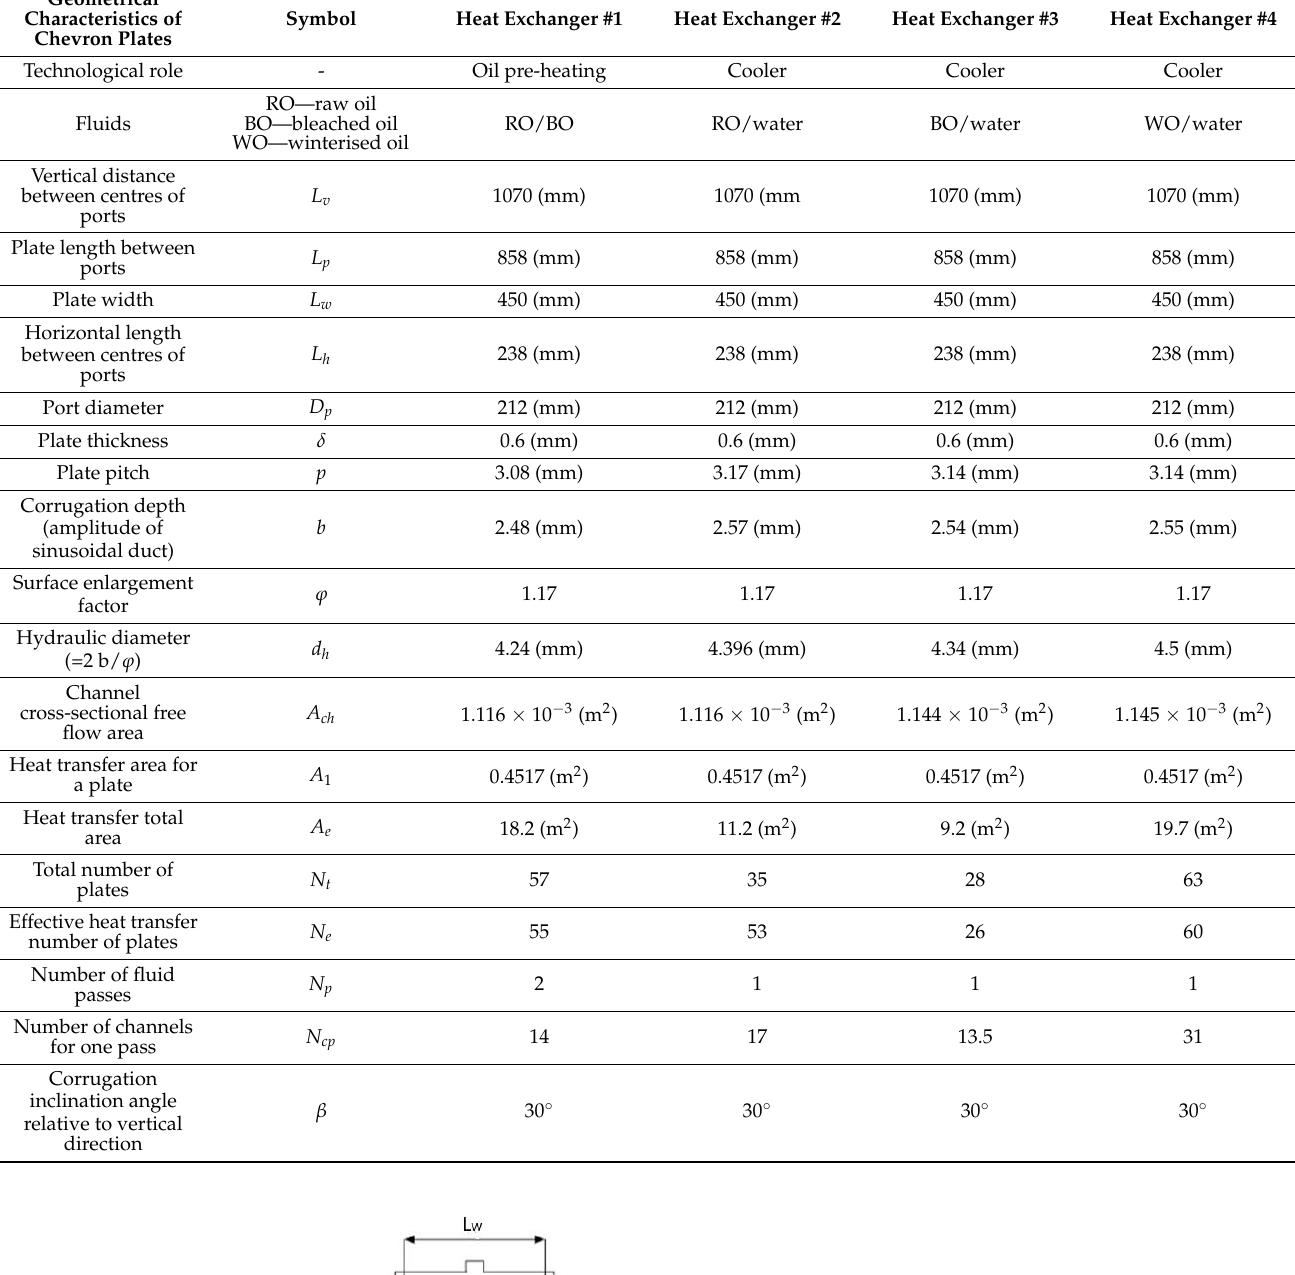
Table 1. The technological role, fluids and geometrical characteristics of the HE.